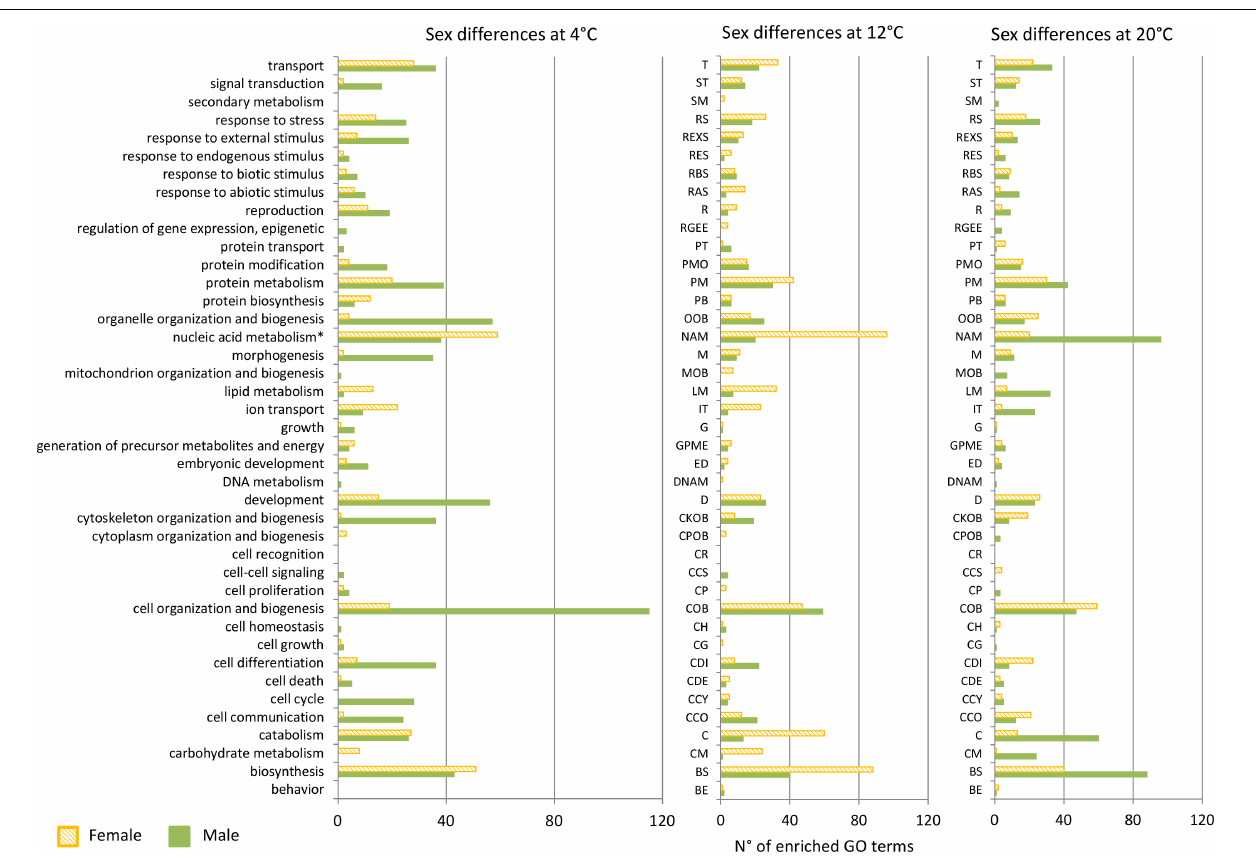
FIGURE 5 | Over-represented GO terms belonging to the ontology Biological Process in male (green) and over-represented in female (orange in diagonal stripes) gametophytes of Saccharina latissima at 4, 12, and 20 ◦ C according to the categories of GO slim (GOseq, p < 0.05, n = 3). Nucleic acid metabolism ∗ stands for nucleobase, nucleoside, nucleotide, and nucleic acid metabolism. Total for the category metabolism at 4 ◦ C – Females: 170, Males: 153, at 12 ◦ C: Females: 354, Males: 120, at 20 ◦ C: Females: 55, Males: